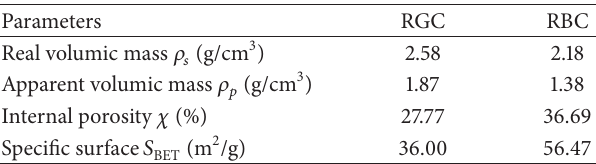
Table 3: Textural analysis of samples.